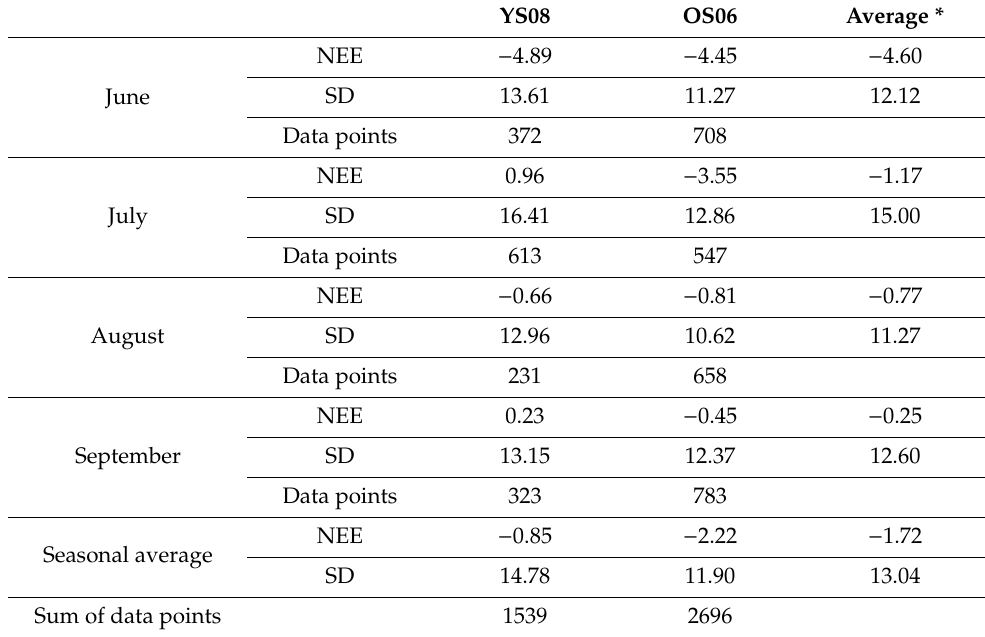
Table 2. Average monthly and seasonal values of NEE (µmol m −2 s −1 ), standard deviations (SD), and data points over the study period.